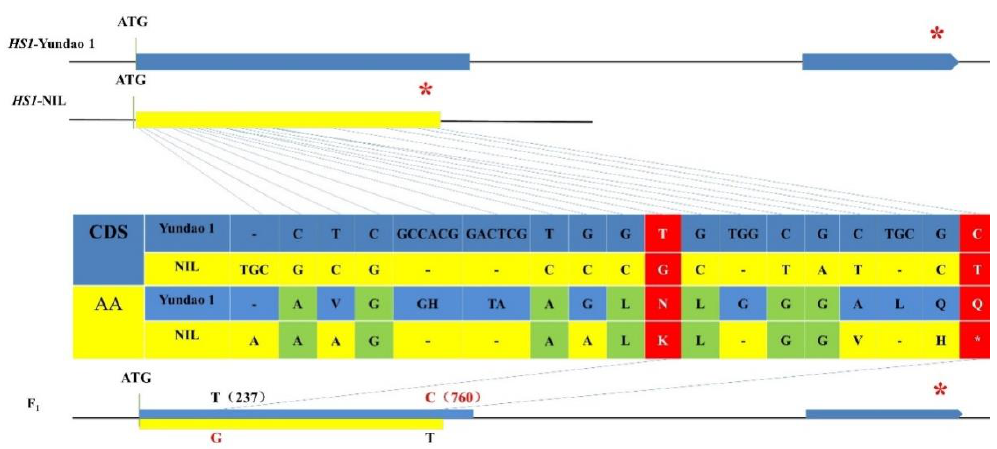
Figure 2. ( A ) Graphical genotypes show that an O. barthii chromosomal segment was introgressed into the NIL- hs1 genome on chromosome 4. ( B ) Genetic mapping of hybrid shattering 1 ( HS1 ) on Chromosome 4, white bar: homozygous Yundao 1; grey bar: heterozygous; black bar: homozygous NIL- hs1 . “R” means the number of recombinants.